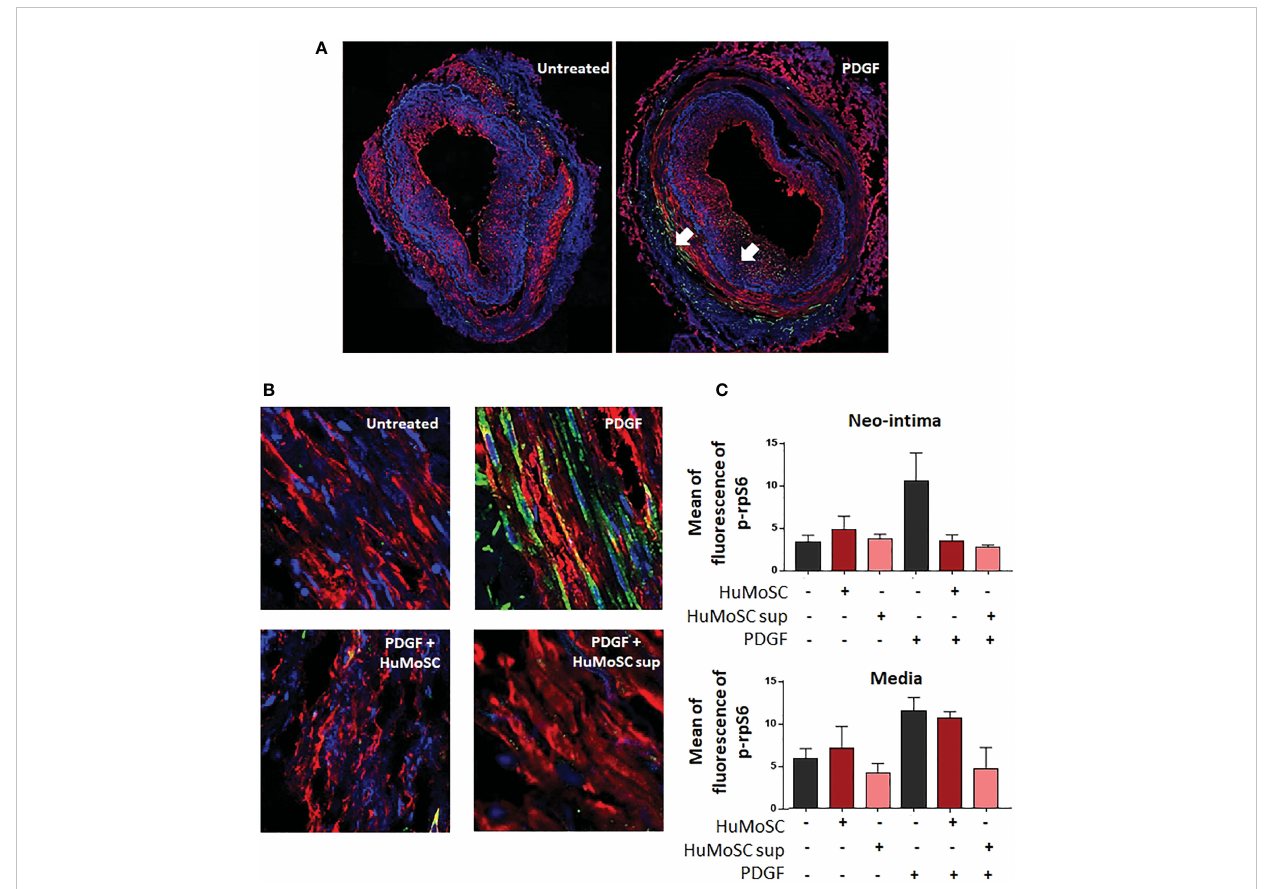
FIGURE 5 Effect ofHuMoSCin the mTORpathway. (A, B) Confocal microscopy analysis of temporal arteries affected by GCA cultivatedduring 5 daysalone or in the presenceof PDGF (20ng/mL),HuMoSC(250.10 3 /mL) orsupernatant of HuMoSC (25%).Pictures show staining of a -SMA(red),p-rpS6 (green)and nuclei (DAPI, blue). p-rpS6, whose expressionis shown by the white arrows, is a metabolite of mTOR. Thus, the intensity of the green stainingre fl ects the activationof the mTORcomplex. Pictures show the entireartery (A) andmagni fi cations (x 40)in the media (B) . (C) Mean ± SEM fl uorescence intensity of p- rpS6 staining normalized to background noise was calculated in the neo-intimaand the media ofeach temporal artery using ImageJ fi ji software(untreated TAB+ [n=5], HuMoSC [n=3], HuMoSC supernatant [n=3], PDGF[n=4],PDGF+ HuMoSC [n=2], PDGF + HuMoSC supernatant